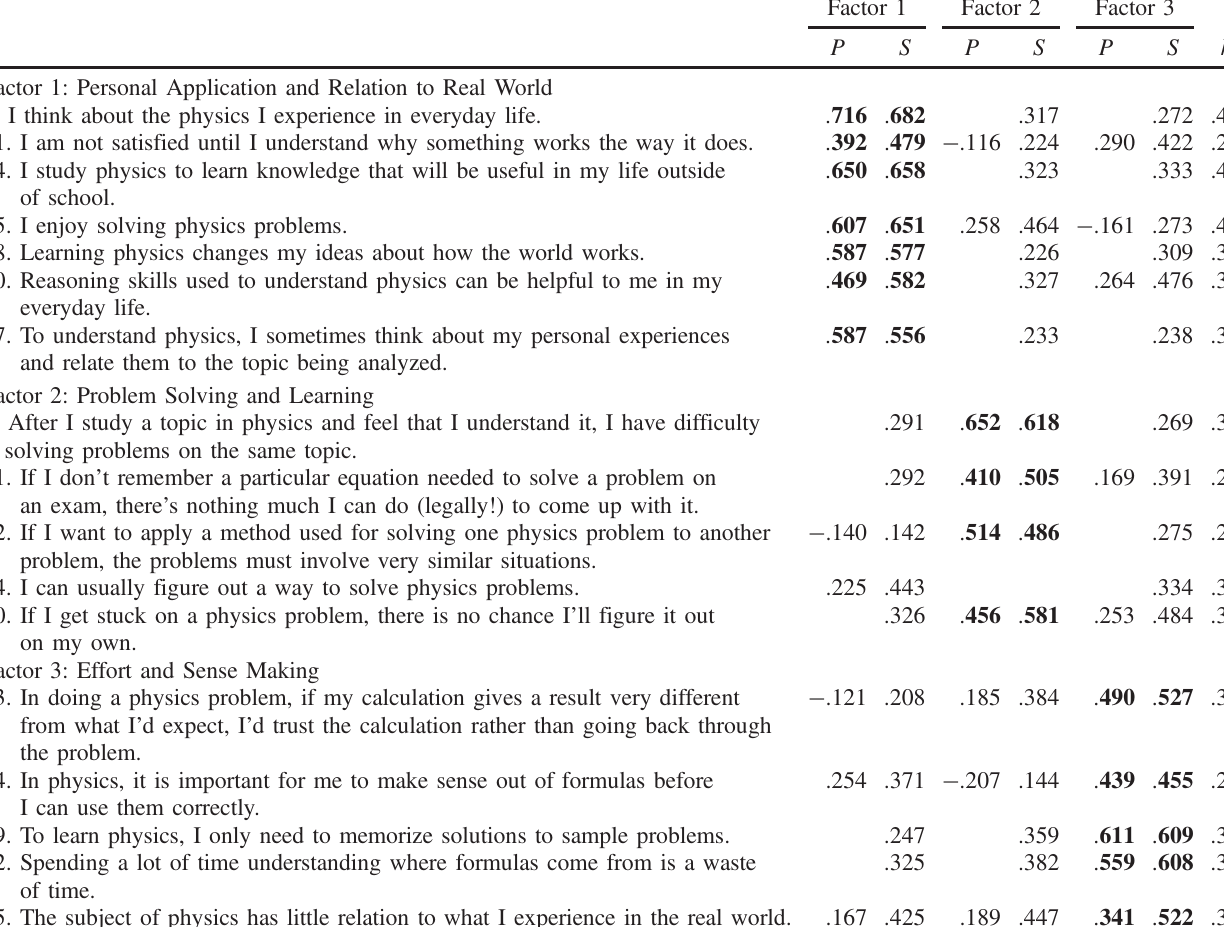
TABLE II. Exploratory factor analysis factor structure.